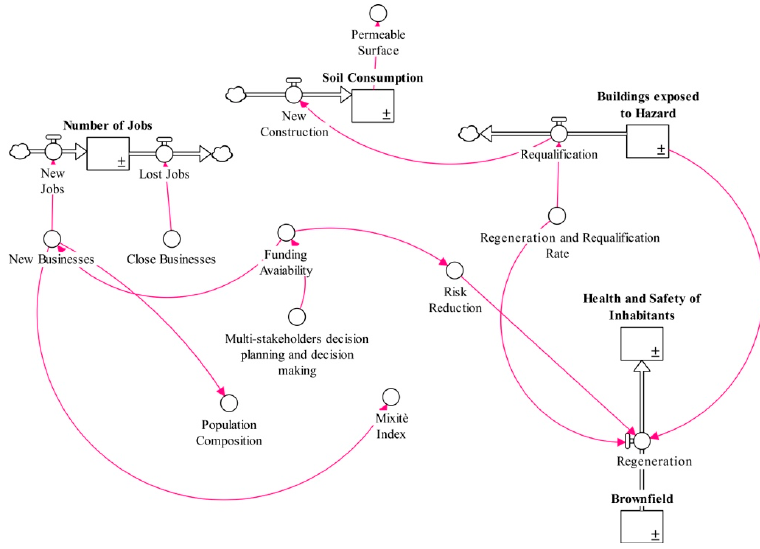
Figure 11. Stock and Flow diagram for the Basse di Stura area (Datola et al., 2019).